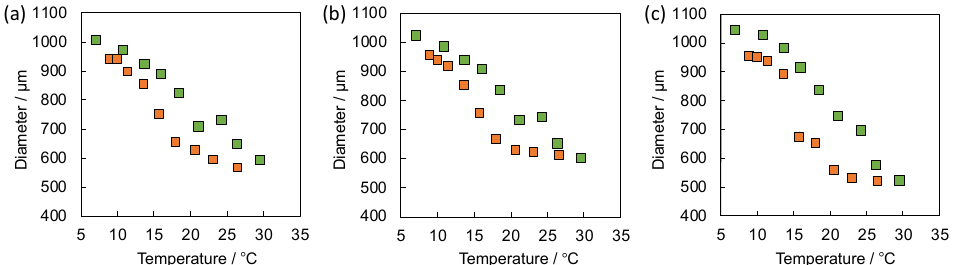
Figure 8. Equilibrium swelling behavior of ( a ) SOG-(1:1), ( b ) SOG-(1.5:1) and ( c ) SOG-(1:1.5) in reduced state (orange) and oxidized state (green) at the various temperatures. The gels were equi- librated in water containing HNO 3 (894 mM) and NaBrO 3 (100 mM) for the oxidized state and in water containing HNO 3 (894 mM) and NaCl (100 mM) for the reduced state.